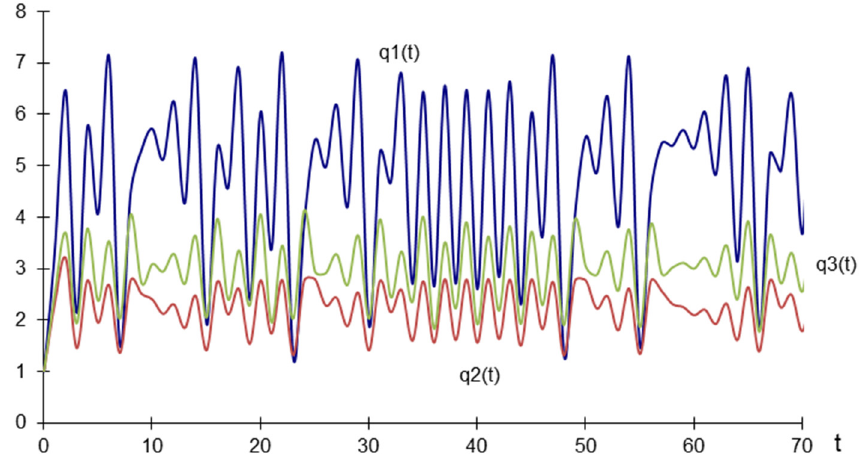
Figure 3. Equilibrium quantities for real expectations—dynamic map.